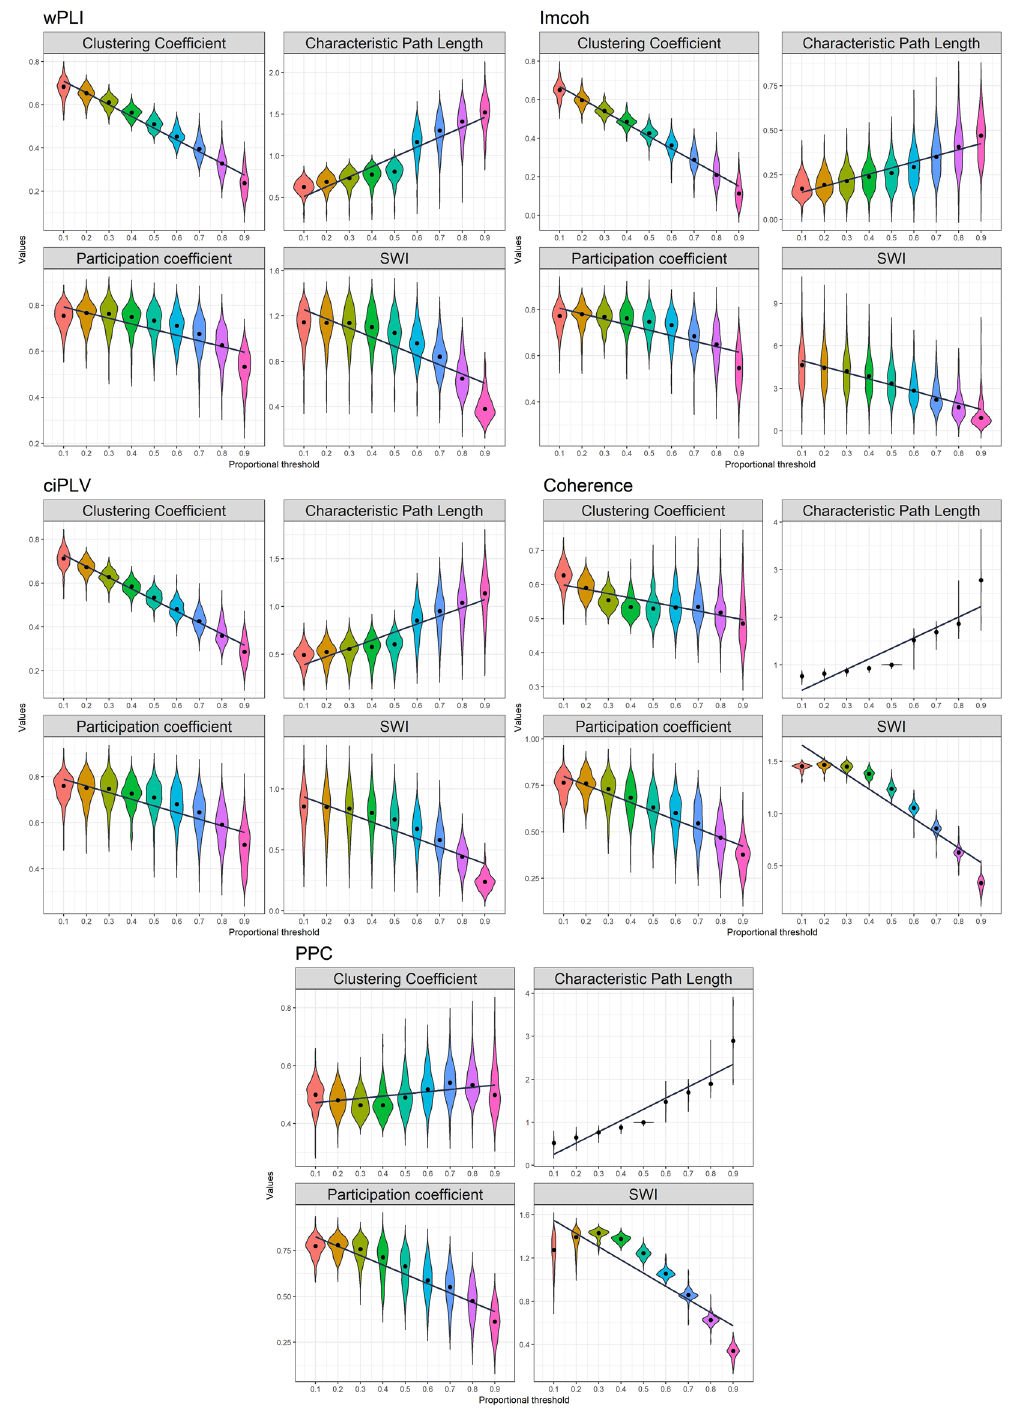
Figure 2. Effect of density thresholding on graph measures in sensor space. Five measures are presented in the following order (top-to-bottom): wPLI, imcoh, ciPLV, coherence, PPC On each plot four measures are presented (left-to-right, top-to-bottom): Clustering Coefficient, Characteristic PL, Participation Coefficient, SWI. The black line represents linear regression over the data. ggplot2 3.3.6 (https:// ggplo t2. tidyv erse. org/) was used to create this